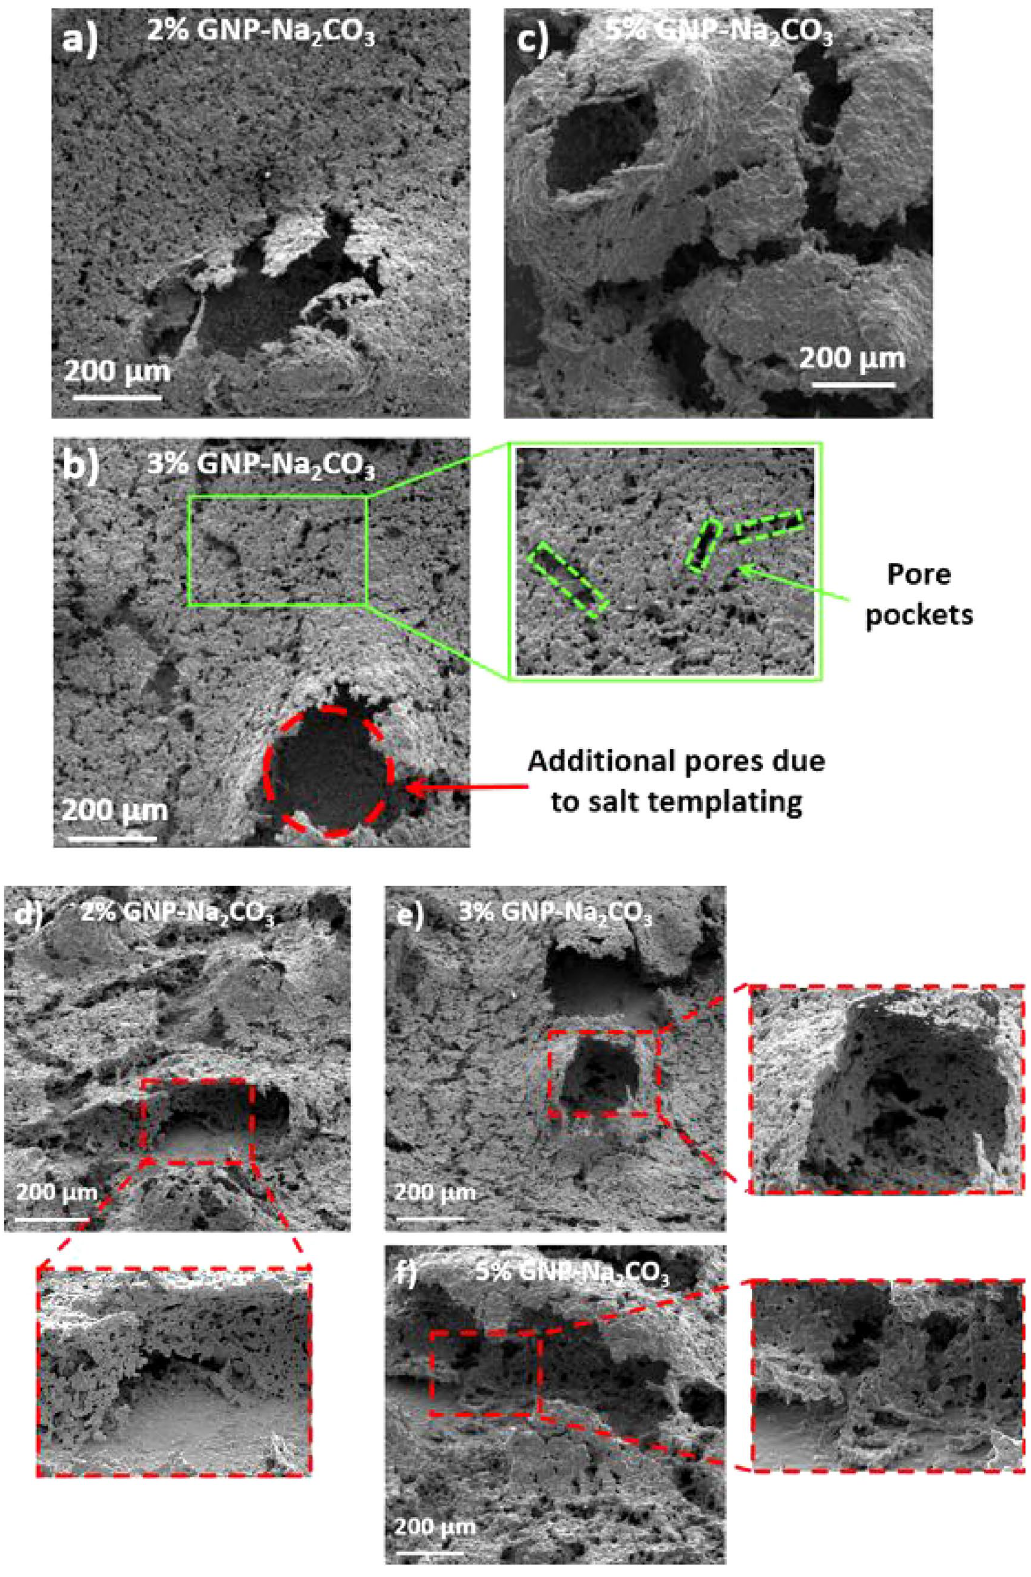
Figure 6. Scanning electron microscope images at 200 × for salt templated GNP draped Cu coatings (20 µm Cu particles) ( a ) 2% GNP, ( b ) 3% GNP, and ( c ) 5% GNP, stage tilted scanning electron microscope images for salt templated GNP draped Cu coatings ( d ) 2% GNP, ( e ) 3% GNP, and ( f ) 5%